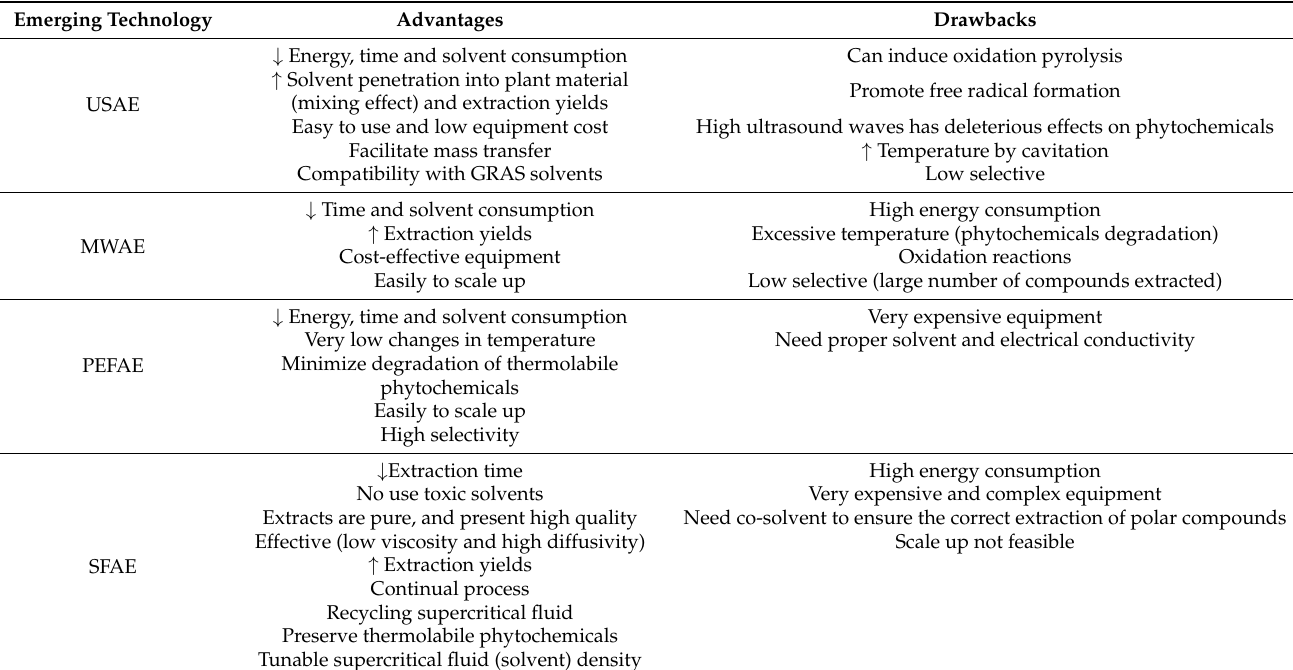
Table 1. Advantages and drawbacks of emerging extraction